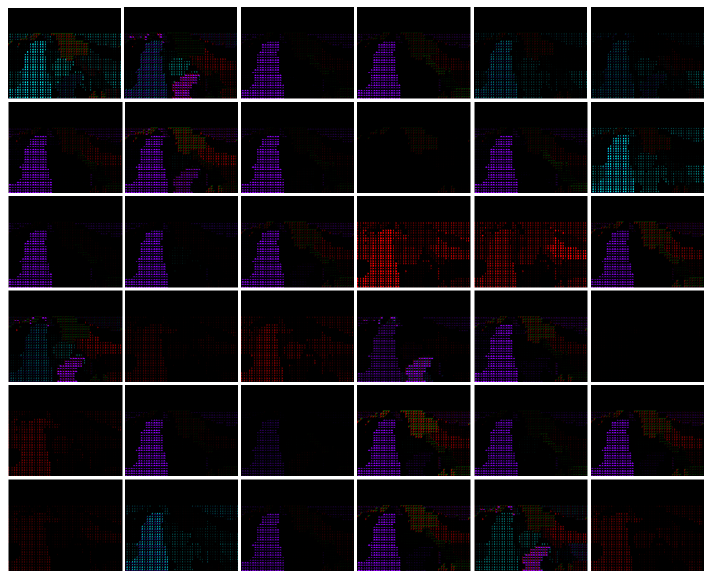
Figure 11. Thirty-six latent motion topics discovered by RTM-HSVG.